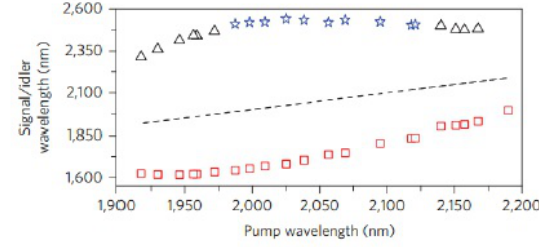
Fig. 15. The phase-matched signal (squares) and idler (stars and triangles) wavelengths as a function of the pump wavelength in the four wave mixing process in the silicon waveguide. The stars represent the calculated idler location (from the measured signal wavelength) as they are outside the bandwidth of the OSA. Adapted from reference [63].